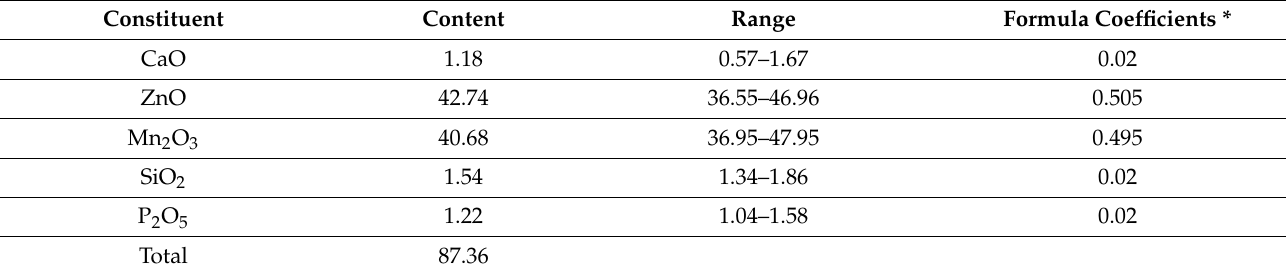
Table 1. The chemical composition of the mineral from Kapova Cave (wt.%, mean of three spot analyses). Constituent